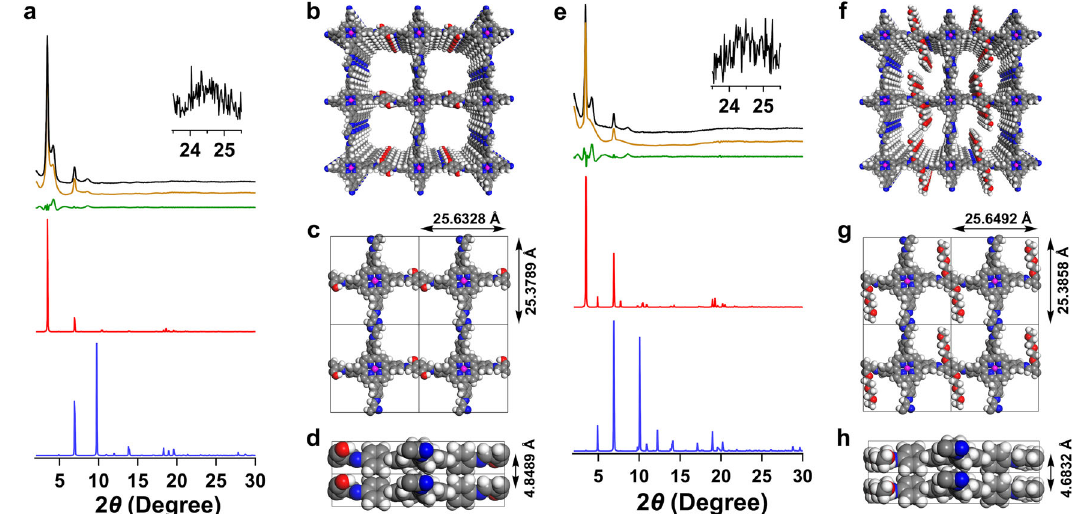
e PXRD pro fi les of ZnP-Pz-PEO-COF (black, experimentally observed; orange, Pawley re fi ned; green, their difference; red, AA-stacking mode; blue, AB-stacking mode). f – h Reconstructed crystal structure of ZnP-Pz-PEO-COF with ( f ) ten layers, ( g ) one layer, and ( h ) two